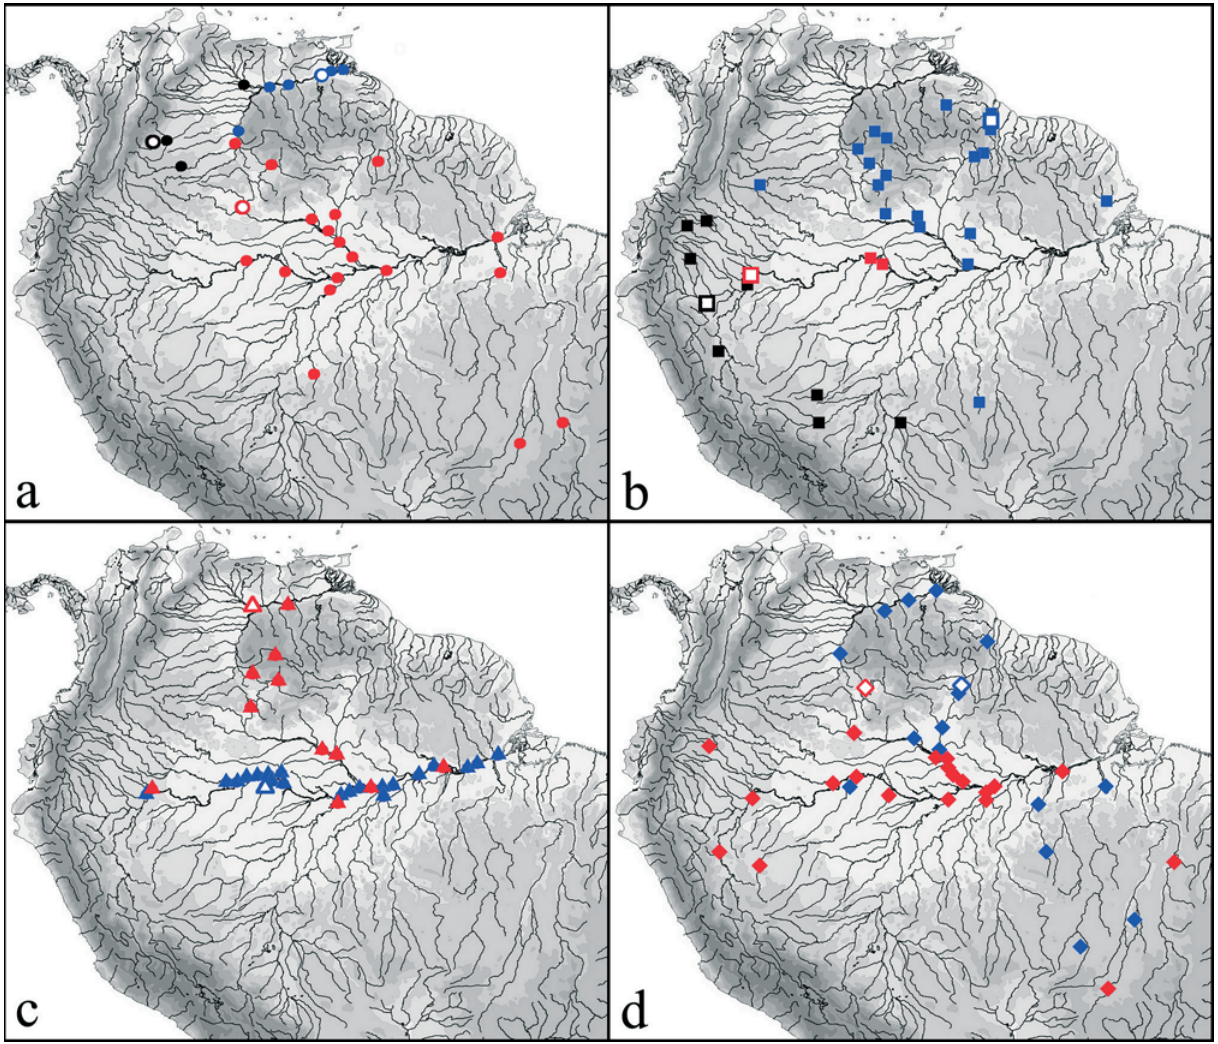
Fig. 15. Distribution of Leptodoras species, based on Sabaj (2005). In a, Leptodoras praelongus represented by red circle, L. nelsoni by black circle, and L. rogersae by blue circle. In b, L. myersi represented by red square, L. acipenserinus by black square, and L. linnelli by blue square. In c, L. copei represented by red triangle, and L. juruensis by blue triangle. In d, L. cataniai represented by red lozenge, and L. hasemani by blue lozenge (type localities represented by opened